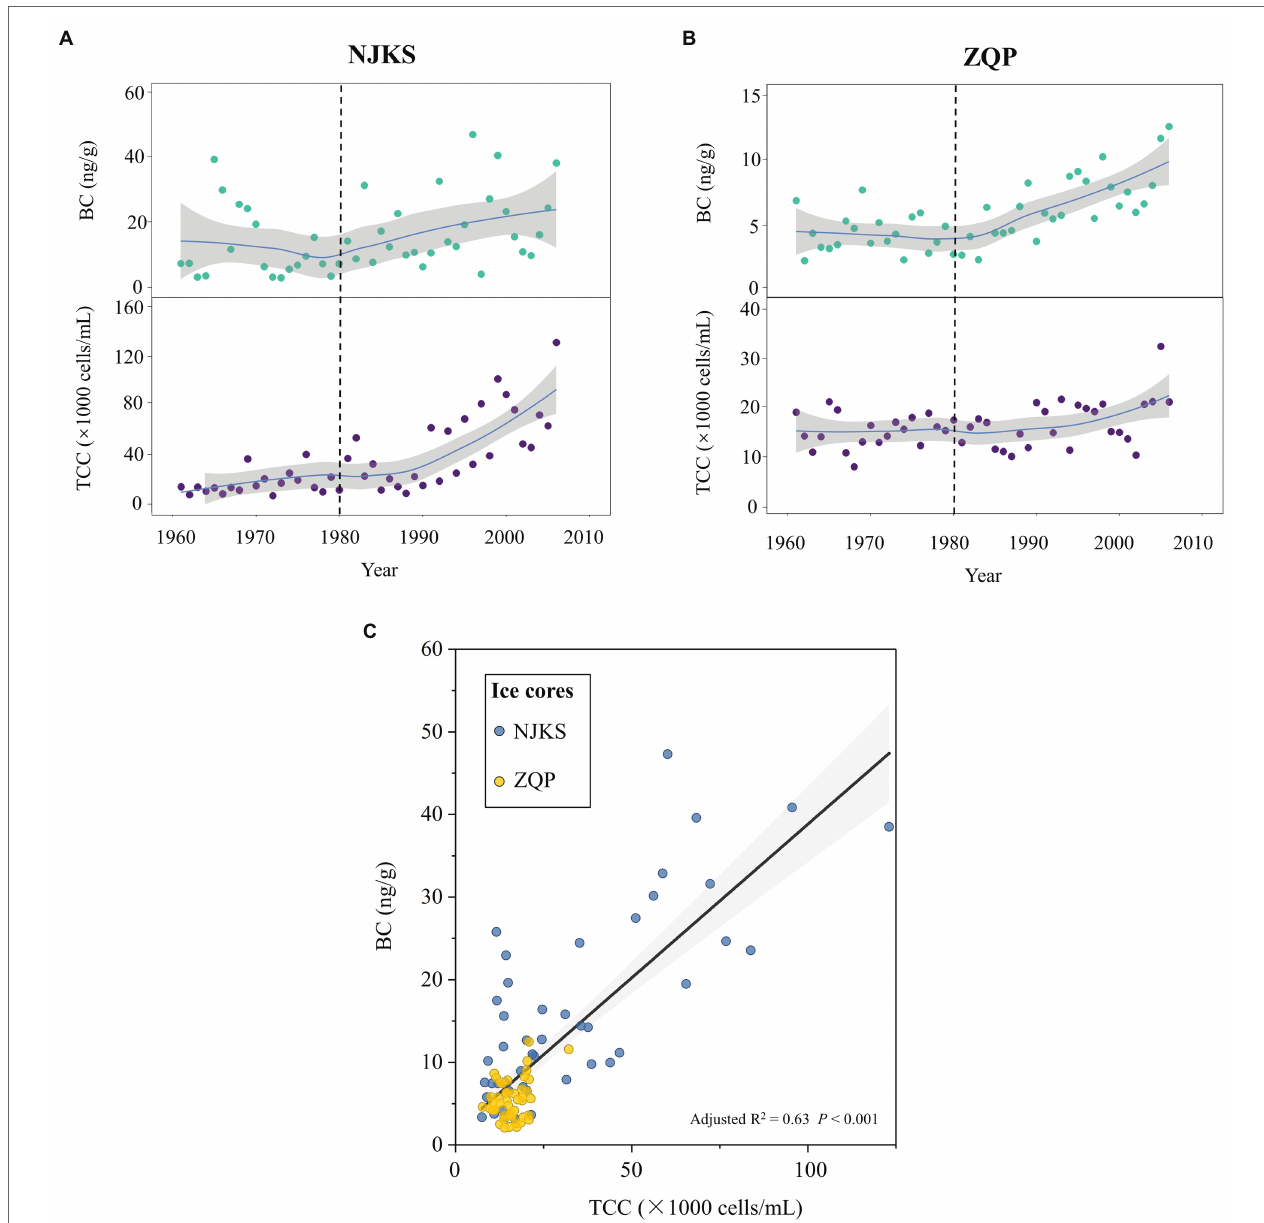
FIGURE 1 | Temporal variation of total cells concentration (TCC) and black carbon (BC) concentration from 1960 to 2006 in Noijinkangsang (NJKS) and Zuoqiupu (ZQP) glacier ice cores and their correlation. Time trends (solid lines) of TCC and BC in NJKS (A) and ZQP (B) . All trends were estimated using GAMs. The gray- shaded areas in the graphs represent the 95% CIs. (C) Correlation between TCC and BC across the two glacier ice cores. The gray-shaded areas in the graphs represent the 95%